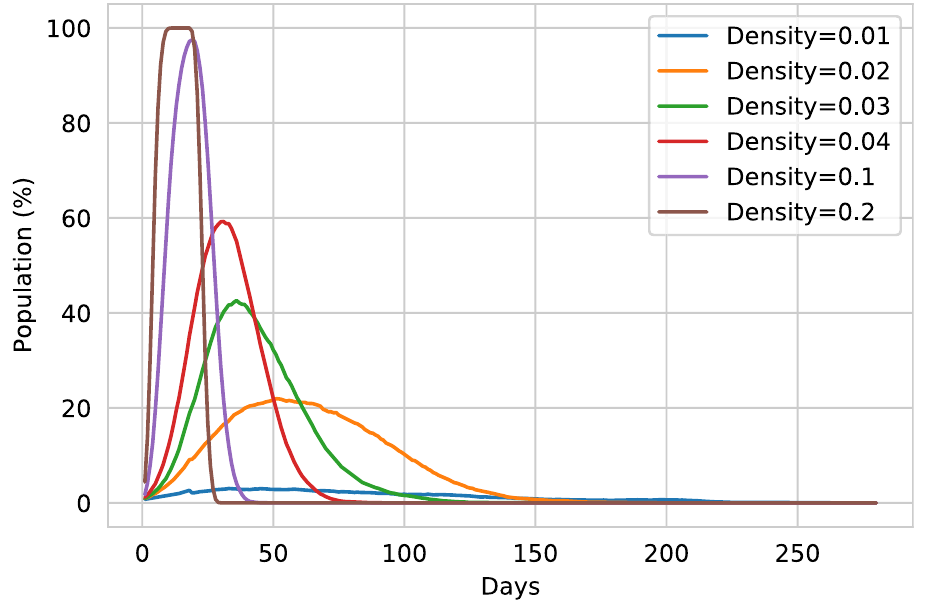
Figure 7. The figure simulates the active cases of the environment, based on different population density. Increasing the density of the population also increases the probability of contact between people. Therefore, the spread of disease also